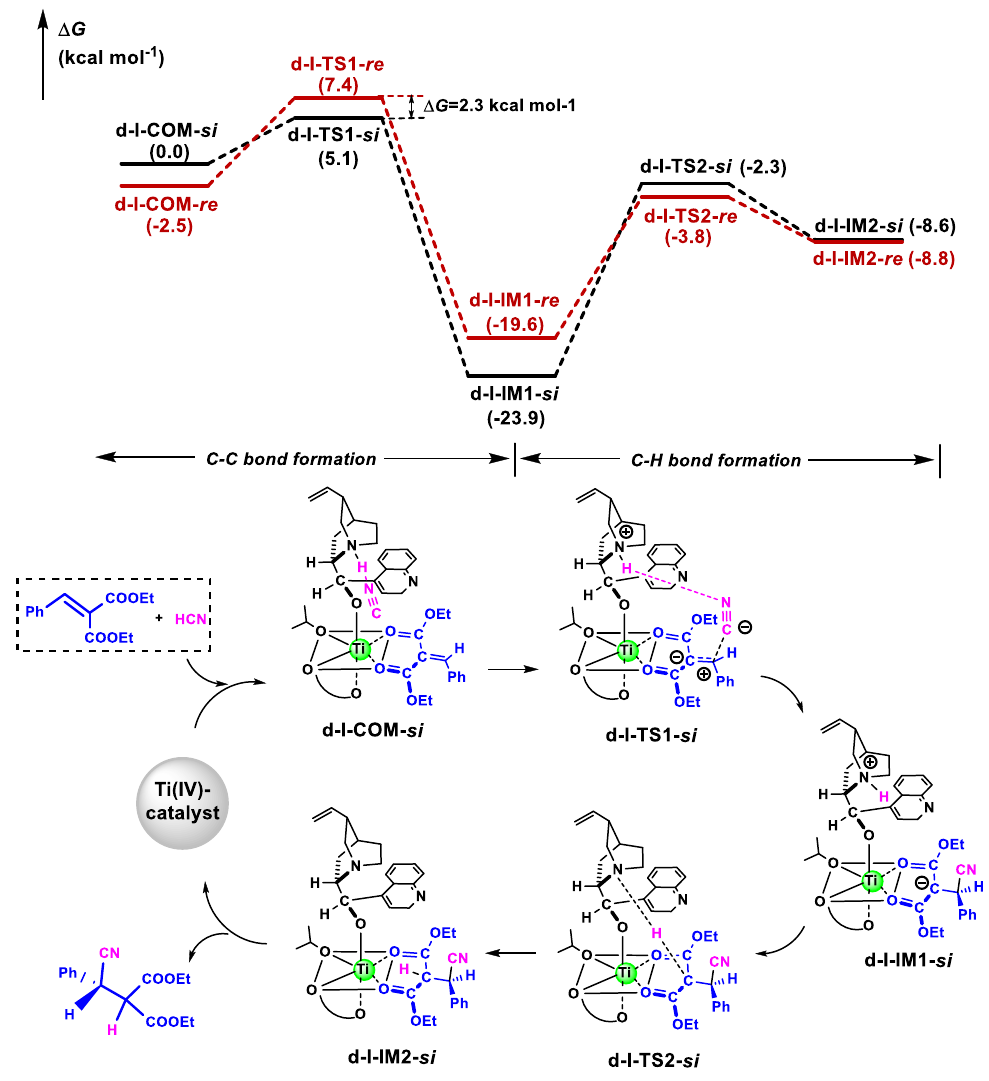
Figure 4. Gibbs free energy profiles for the catalytic cyanation of olefin mediated by Ti(IV)-complex along si - and re -face attack pathways and schematic catalytic cycle along si -face attack pathway as a representative.